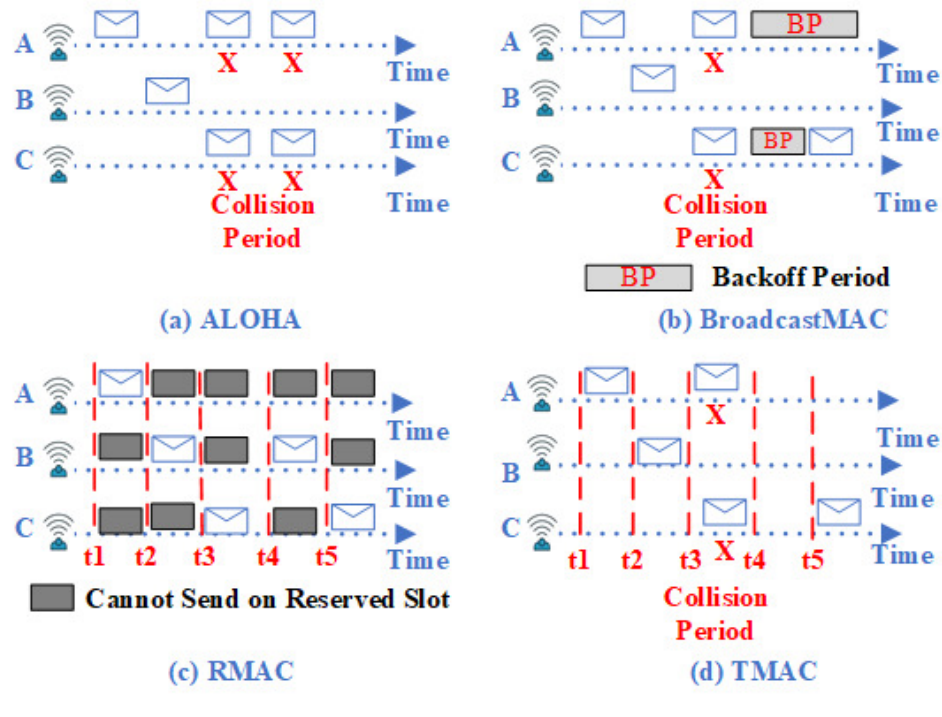
Figure 2. Operations of MAC Protocols [34] @ 2021